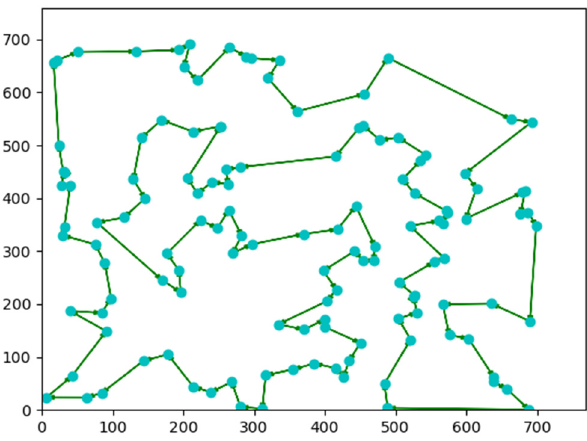
Figure 18. DTLBO solution for Ch130.